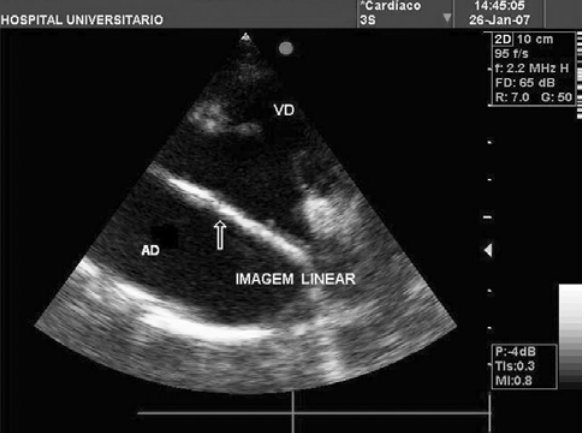
Fig. 1 - Ecocardiograma mostrando imagem linear densa intra- atrial direita